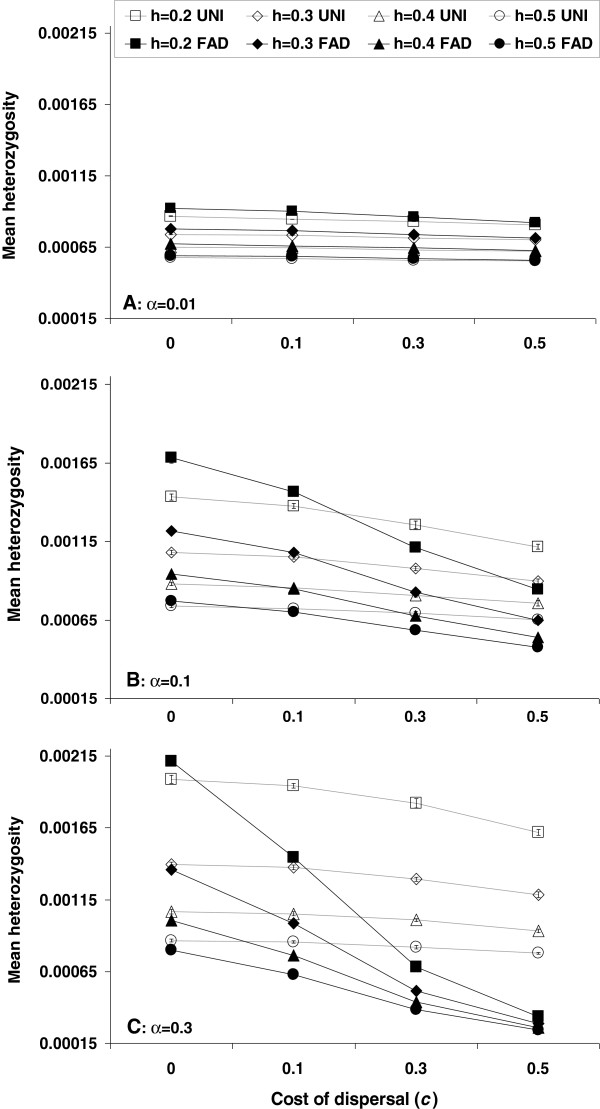
Mean heterozygosity under different dispersal rules. Mean frequency (±SE) of deleterious heterozygous alleles at the steady state in populations homogeneous at the modifier locus - either FAD allele (filled markers) or UNI allele (open markers). Heterozygosity is plotted as a function of the cost of dispersal c, of the dominance coefficient h, and of the mean dispersal rate (A: α = 0.01, B: α = 0.1, C: α = 0.3). Heterozygosity decreases as h increases in all cases, because the masking of deleterious mutations in a heterozygous state is less efficient. Under both dispersal rules heterozygosity decreases with c, because fewer dispersers - which are likely to be outcrossers - survive; but the effect is stronger under FAD, because under FAD individuals carrying many deleterious mutations are more likely to disperse and pay the cost of dispersal. Comparing Figures 2 and 3, heterozygosity with FAD tends to be higher when mean fitness is lower, but not always to the same extent (see, for example, the effect of c in Figure 2C compared with Figure 3C). Note that in most cases the error bars, showing the standard error of the mean, are smaller than the markers.